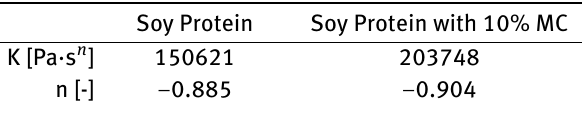
Table 1: Values of the power-law fit for complex viscosity of soy protein and soy protein with 10% methylcellulose. R 2 > 0.999 for both fits. Soy Protein Soy Protein with 10%